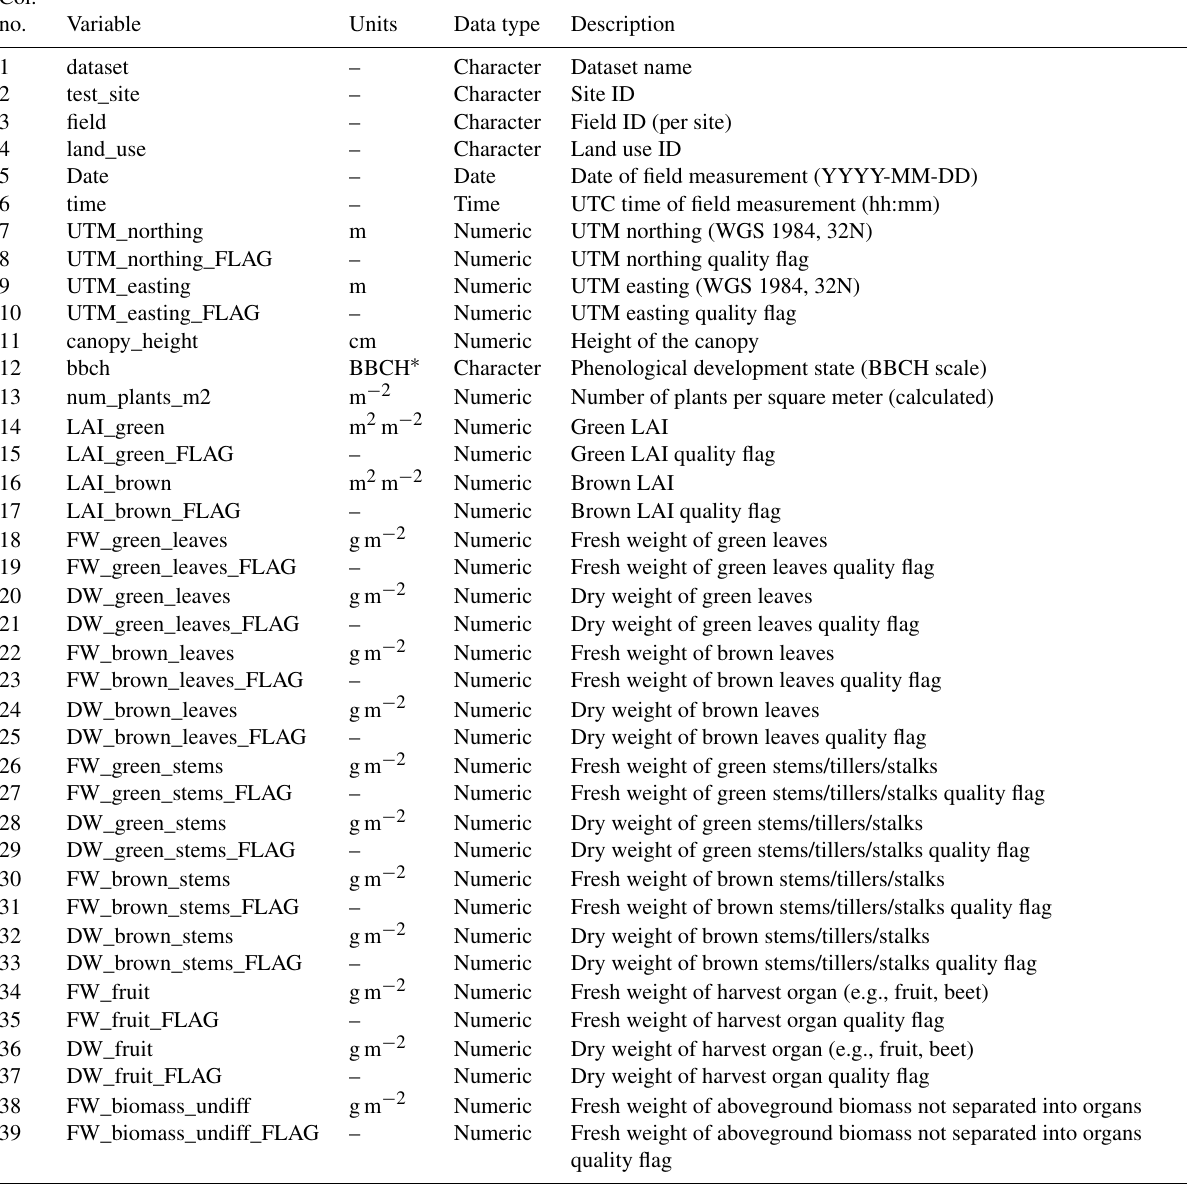
Table A1. Columns in the vegetation data